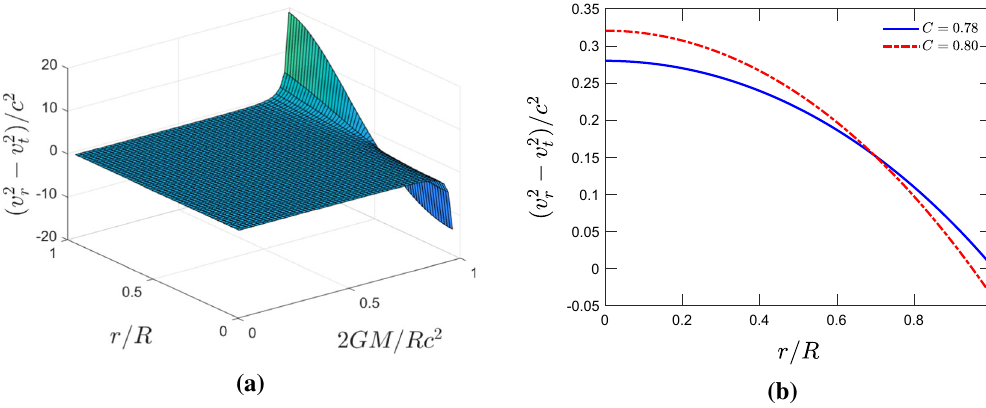
Fig. 4 For sufficiently high compactness, stability against cracking as in condition (39) is violated